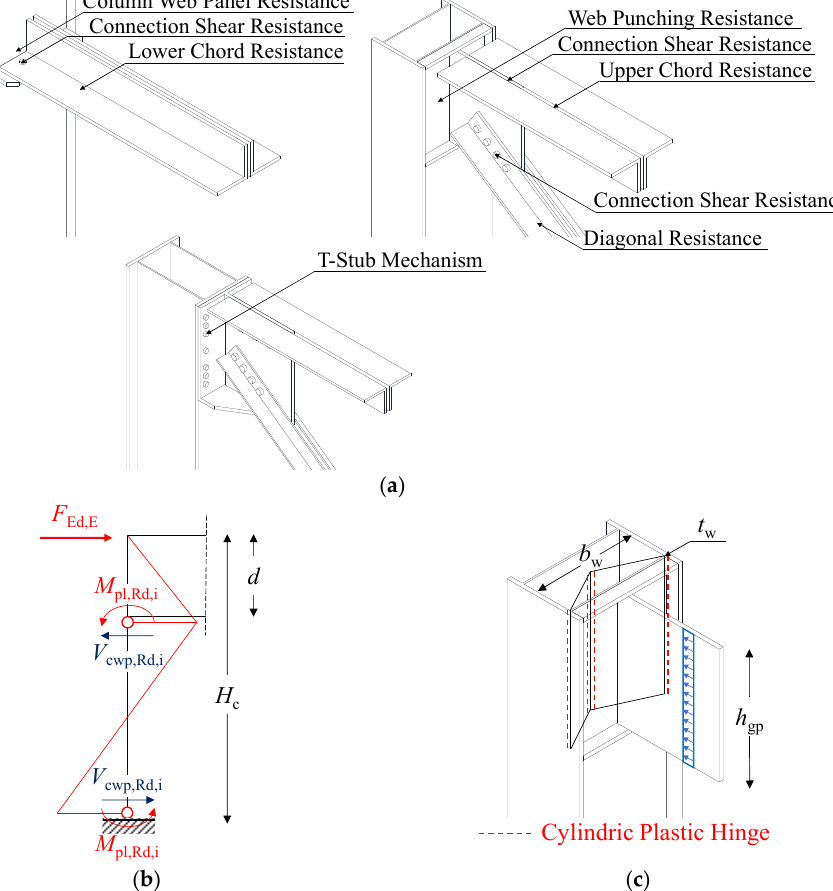
Figure 6. Considered failure mechanisms in MR truss connections for the design of local retrofitting interventions and assumed schemes for the estimation of resistance ( a ): column hinging ( b ) and web punching ( c ).